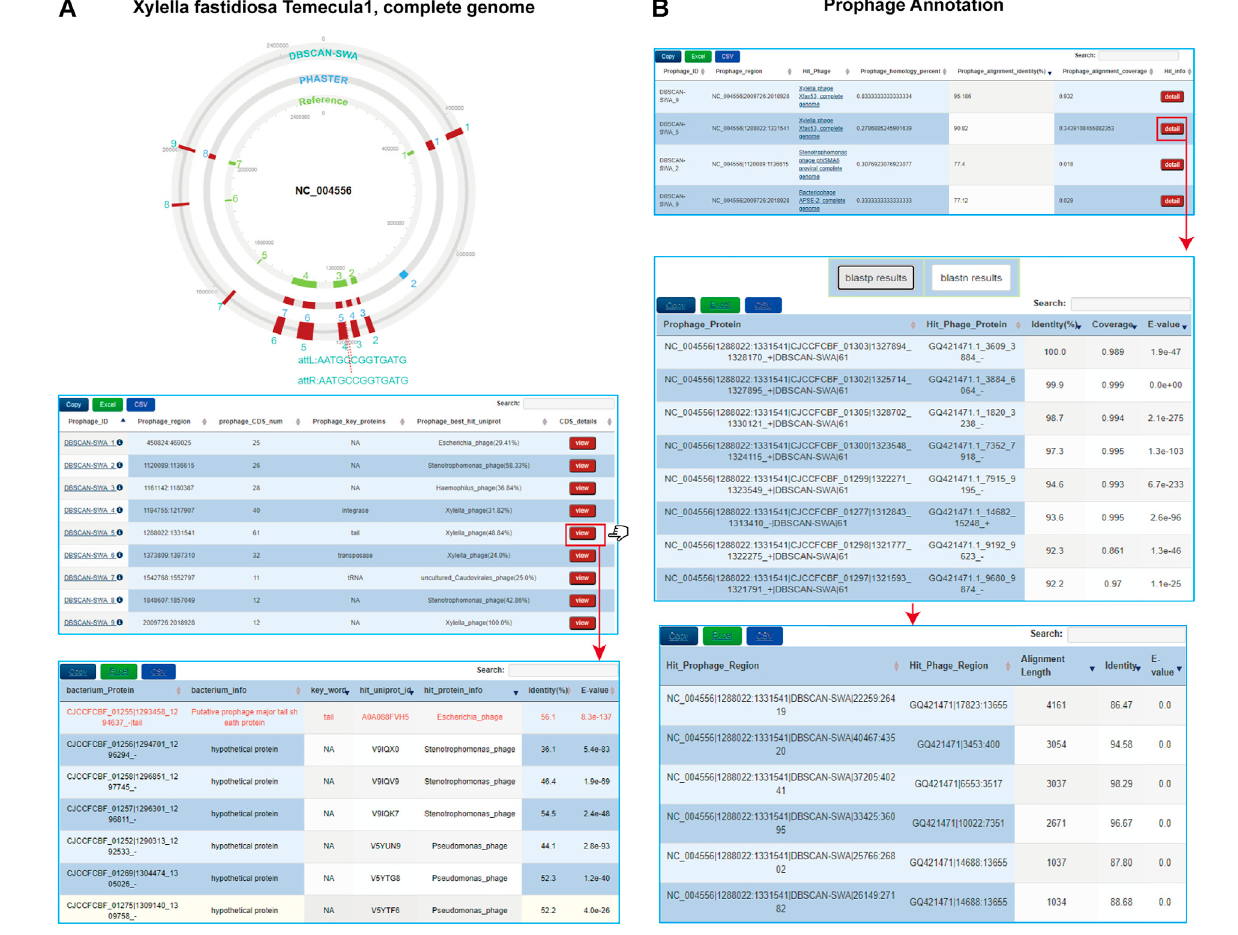
Frontiers in Genetics |